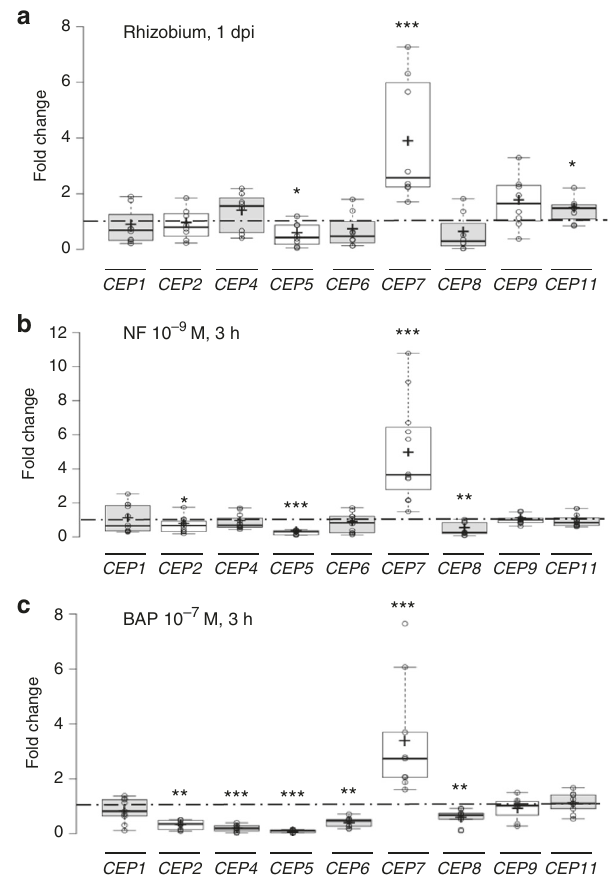
Fig. 1 Expression of CEP peptide-encoding genes in response to rhizobia, Nod factors, or cytokinins. a Expression analysis of CEP genes in wild-type (WT) roots 1 day post rhizobial inoculation (1 dpi). qRT-PCR was used to measure the CEP gene expression levels, normalized relative to uninoculated roots. To highlight fold changes, the dotted line corresponds to a ratio of 1. Data points from four biological replicates are plotted as open circles ( n = 8). b Expression analysis of CEP genes in WT roots in response to a Nod factor (NF) 10 − 9 M treatment for 3 h. qRT-PCR was used to measure the CEP expression levels in treated roots. The results were normalized relative to untreated roots. To highlight fold changes, the dotted line corresponds to a ratio of 1. Data points from six biological replicates are plotted as open circles ( n ≥ 11). c Expression analysis of CEP genes in WT roots in response to a cytokinin (BAP 10 − 7 M) treatment for 3 h. qRT-PCR was used to measure the CEP gene expression levels in treated roots. The results were normalized relative to untreated roots. To highlight fold changes, the dotted line corresponds to a ratio of 1. Data points from four biological replicates are plotted as open circles ( n ≥ 8). In a – c , center lines show the medians; box limits indicate the 25th and 75th percentiles as determined by the R software; whiskers extend 1.5 times the interquartile range from the 25th and 75th percentiles, outliers are represented by dots; and crosses represent sample means. Mann – Whitney test was used for each gene to assess signi fi cant differences between treated and control conditions, as indicated by asterisks (* α < 0.05; ** α < 0.01; *** α <